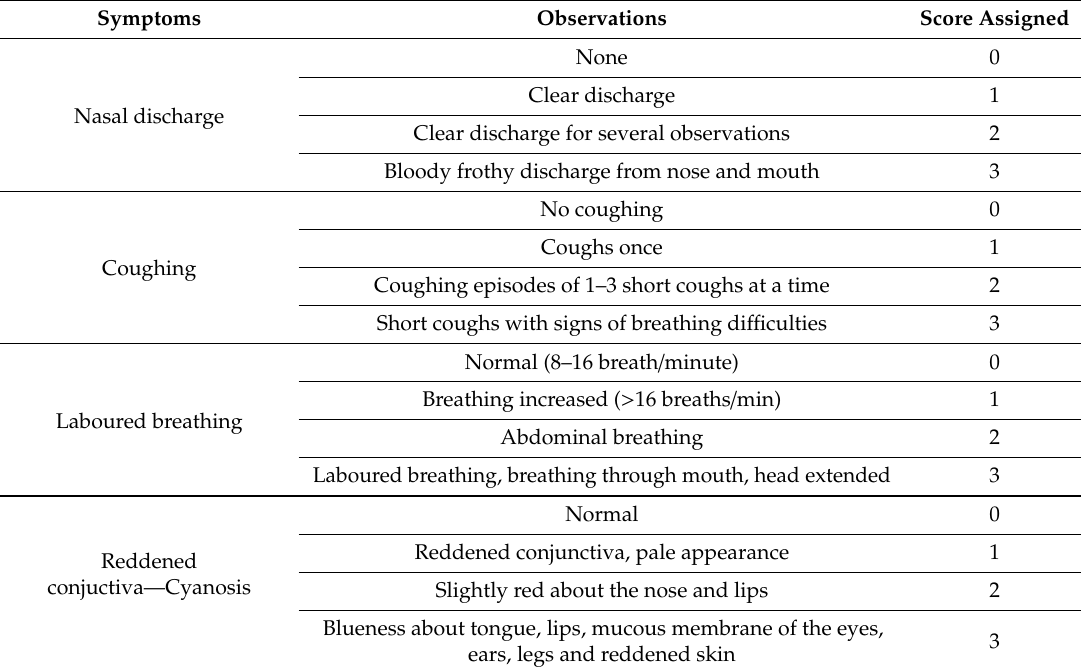
Table 1. Clinical observations and scoring system used to identify animals with symptoms of Actinobacillus pleuropneumoniae (APP)